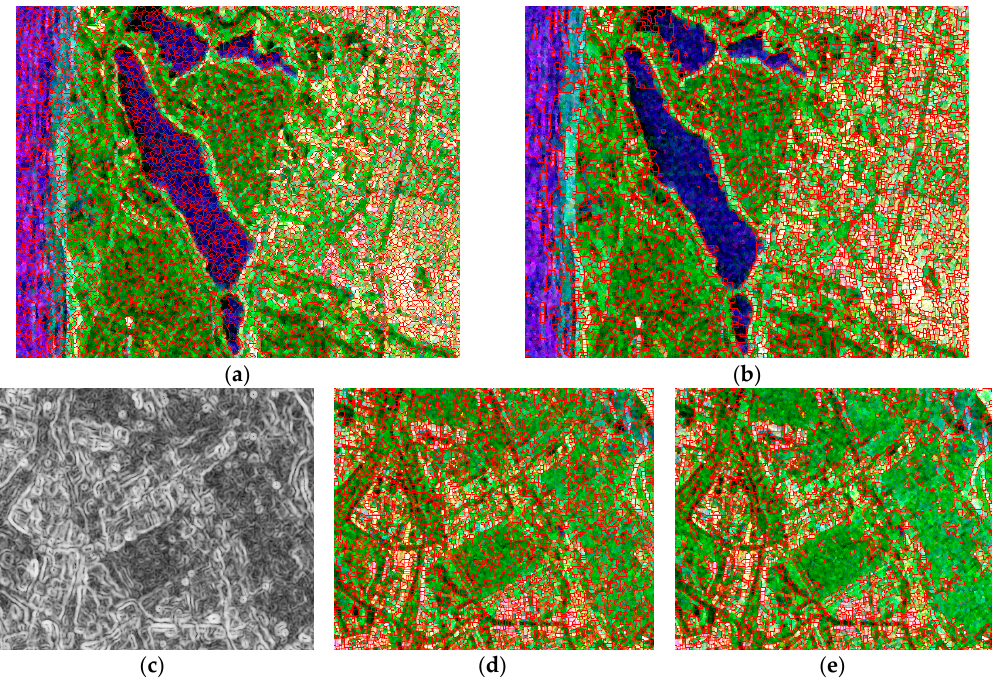
Figure 9. Part of the segmentation result, where the red line presents the boundary. ( a ) The result obtained by simple linear iterative clustering (SLIC), with desired super-pixel number k = 135,000, compactness m = 0.1, and 10 iterations; ( b ) The result obtained used our proposed method in the same region with the parameter λ = 0.8; ( c ) Part of the edge mapping values obtained with Equation (15); ( d ) The segmentation result of the same region with; ( e ) The segmentation result with λ =